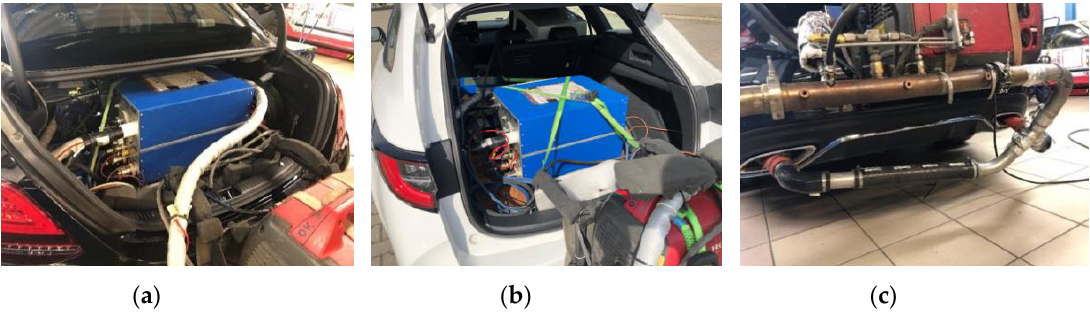
Figure 5. Measurement equipment used for the tests under real tra ffi c conditions ( a – c